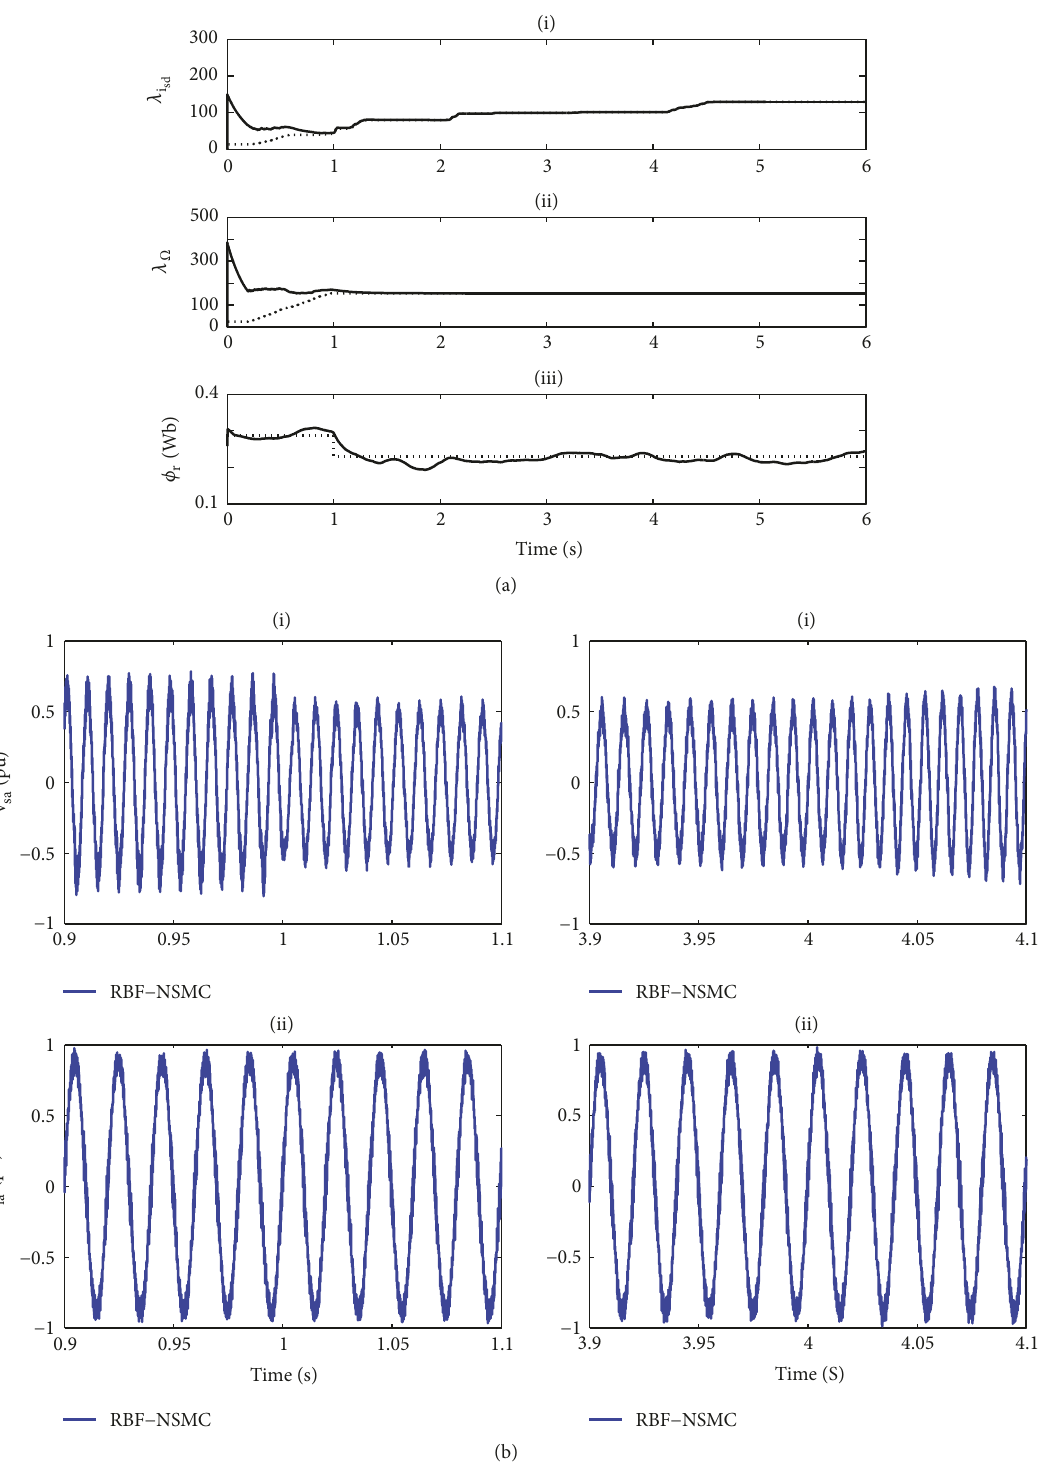
Figure 11: Control system response to wind speed fluctuations with parameters uncertainties (at time 𝑡 = 1𝑠 , variations of +100 % for 𝑅 𝑠 , −20 % for 𝜙 +30 % for 𝐽 are introduced). (a) Estimated parameters. (i) 𝜆 +50 % for 𝐿 𝑠 , 𝑟 , and ̂𝜆 ̂𝜆 ∗ 𝜆 its transformed estimate ( Ω : (dotted line) estimate ( Ω ) and (solid line) its transformed estimate ( 𝑖 𝑠𝑑 ), (ii) reference and (solid line) its estimate. (b) Zoom on control signals: (i) approximation of phase −𝑎 voltage of the MSC ̂ V ∗ 𝑠𝑎 ; (ii) phase −𝑎 voltage of the GSC V ∗ 𝑖𝑎